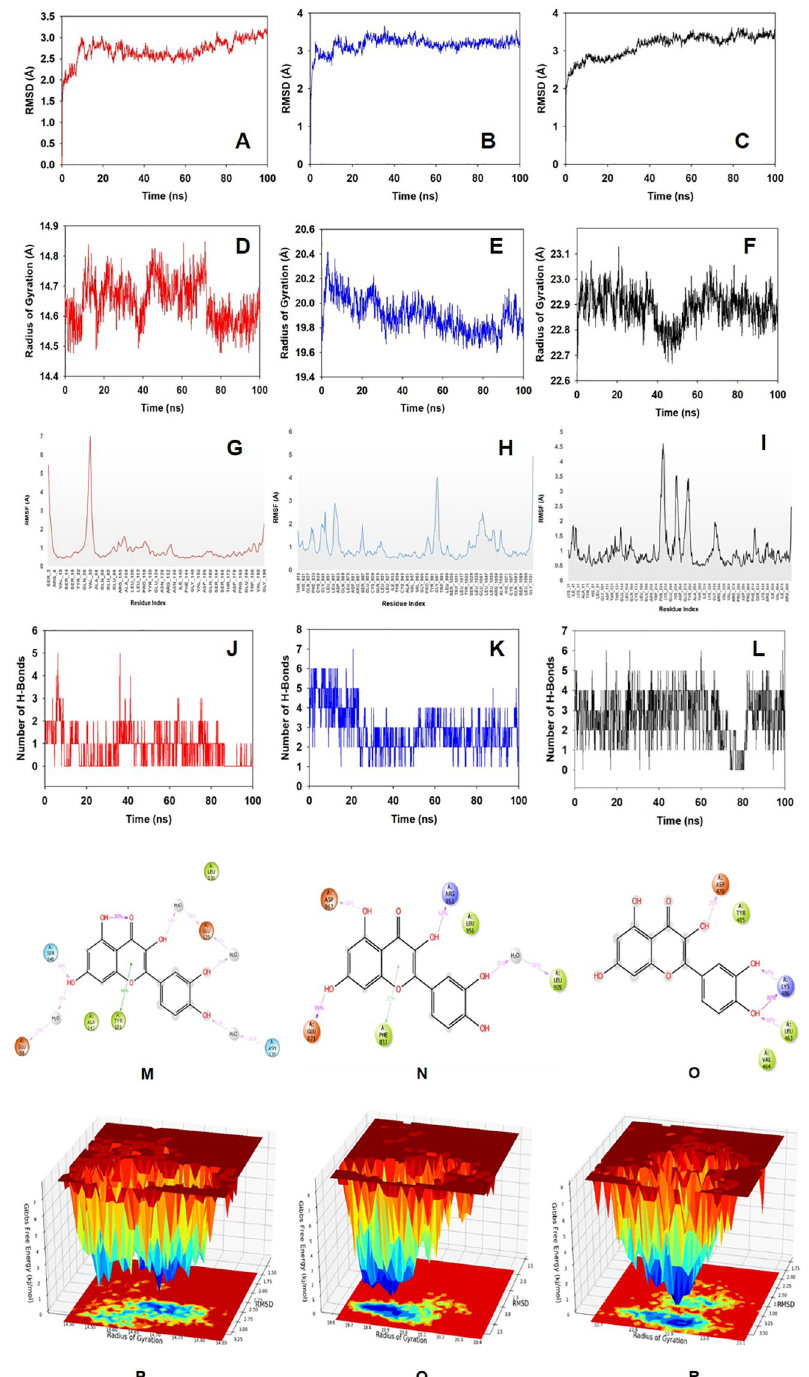
Fig 3. Analysis of MD simulation trajectories for 100 ns. RMSD plots displaying the molecular vibrations of C α backbone of (A) BCL-2 (B) JAK2 and (C) Cyp2E1. Radius of gyration plots for the deduction of compactness of protein (D) BCL-2, (E) JAK2 and (F) Cyp2E1. RMSF plots showing the fluctuations of respective amino acids throughout the simulation time 100 ns for (G) BCL-2, (H) JAK2 and (I) Cyp2E1. Number of Hydrogen bonds formed during the course of simulation between quercetin and (J) BCL-2, (K) JAK2 and (L) Cyp2E1. 2D interaction plot of post simulation time between the quercetin and (M) BCL-2 (N) JAK2 and (O) Cyp2E1. Free Energy Landscape displaying the achievement of global minima ( Δ G, kj/mol) of (P) BCl-2 (Q) JAK2 and (R) Cyp2E1 in presence of quercetin with respect to their RMSD ( Å ) and radius of gyration (Rg, Å ).